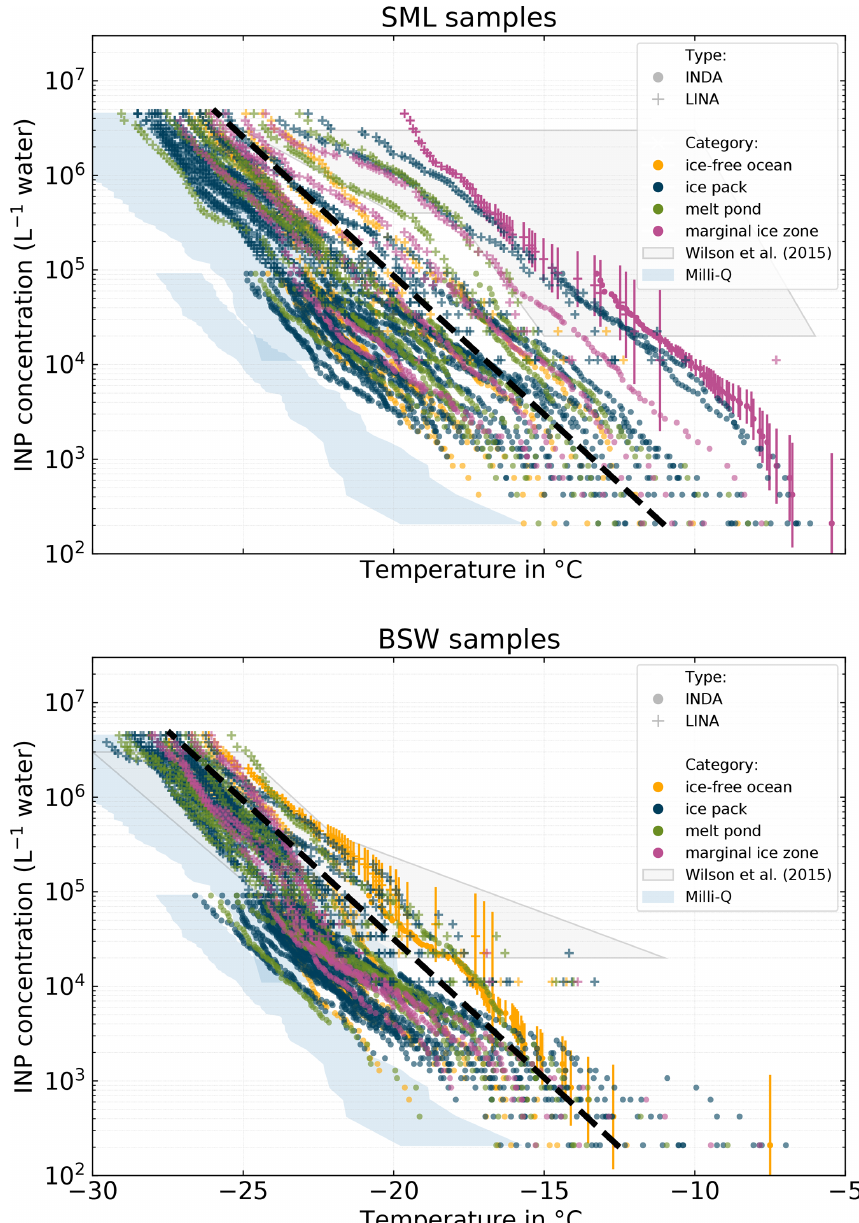
Figure 5. N INP in SML and BSW measured with INDA and LINA. Samples are categorized according to the environment (ice-free ocean, ice pack, melt pond, marginal ice zone) the samples were taken from. The gray box indicates the range of values reported by Wilson et al. (2015) for the Arctic. The blue areas depicts the 10th to 90th percentile range of all pure Milli-Q measurements with INDA and LINA.